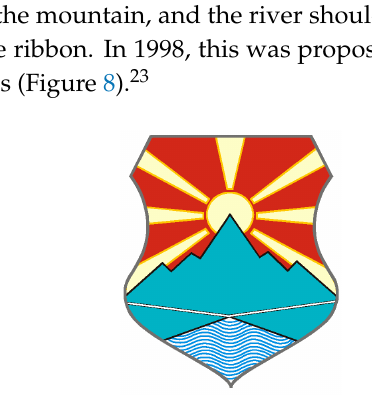
Figure 8. “Slovenian solution” by Darko Gavrovski ( Гавровски 2001).